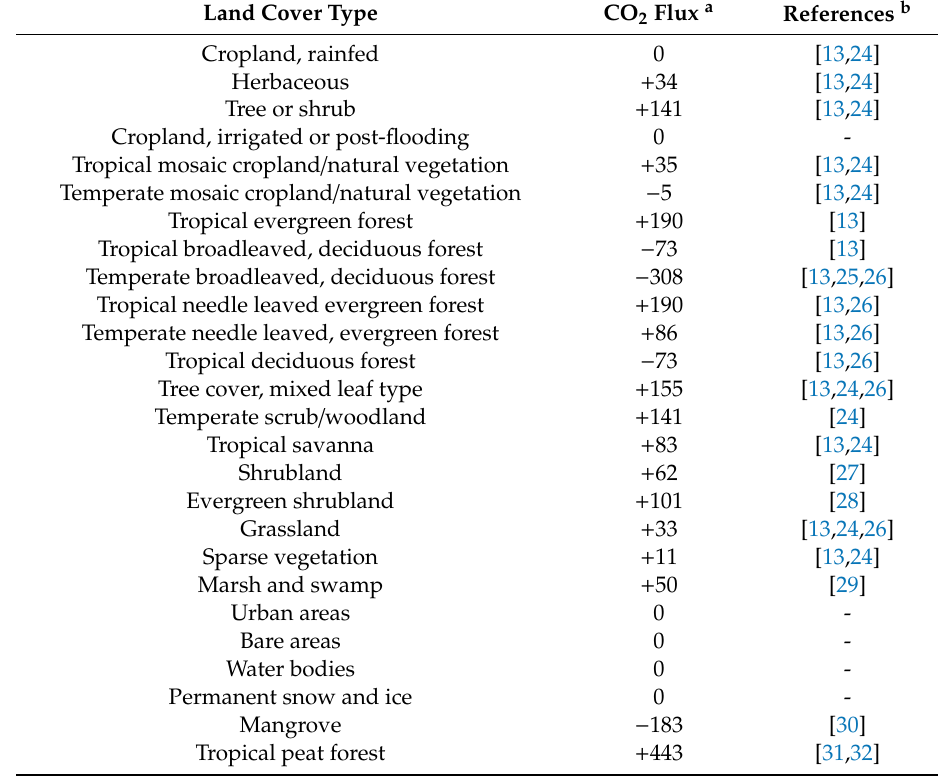
Table 1. Atmosphere exchange of CO 2 of each undisturbed land cover